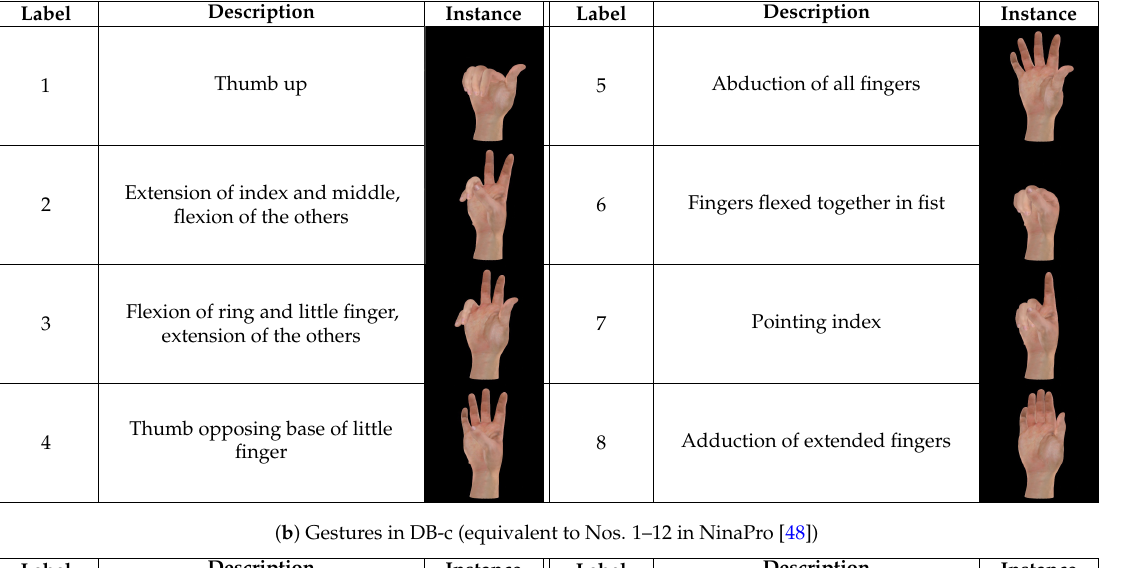
Table 1. Gestures in CapgMyo. ( a ) 8 isometric and isotonic hand configurations; ( b ) Twelve basic movements of the fingers; ( c ) Gestures performed to estimate the maximal voluntary contraction (MVC) force. The instances are the screenshots of the guiding virtual